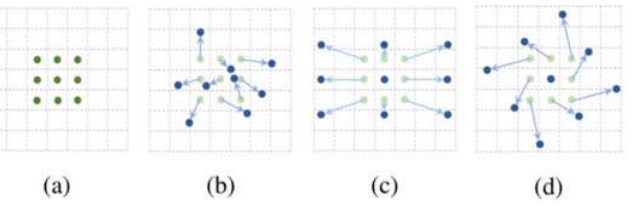
Figure 9. DCN sampling process. ( a ) normal process; ( b ) deformable process; ( c ) widen process; ( d ) rotary process. ( d ) rotary